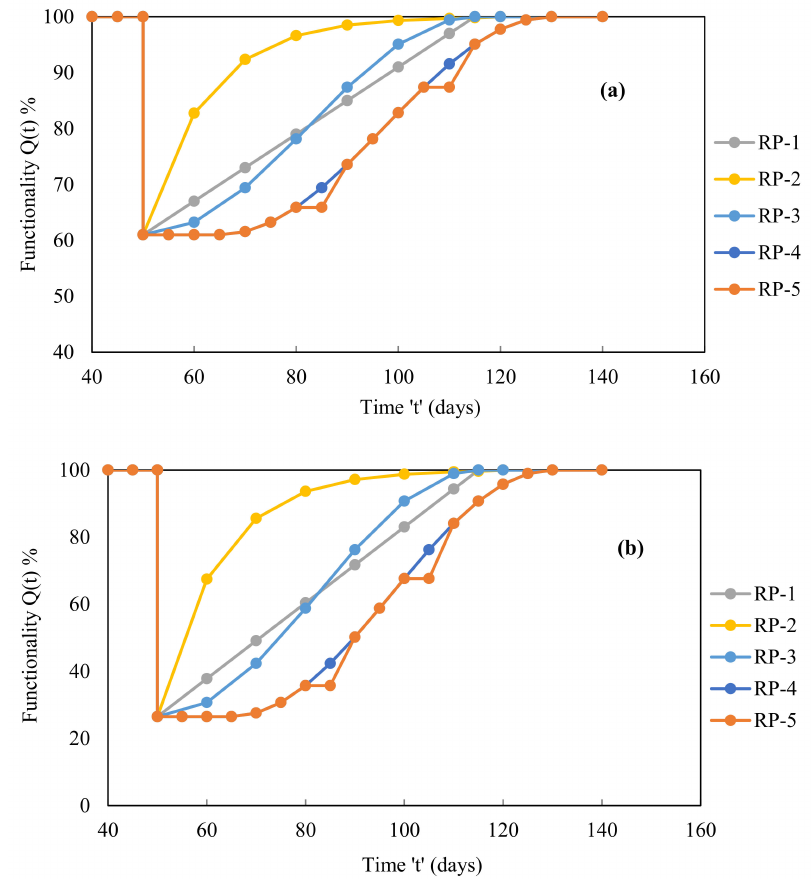
Figure 17. Functionality curves for unsymmetrical building Case I (R = 3) using various recovery paths ( a ) with respect to DBE level and ( b ) with respect to MCE